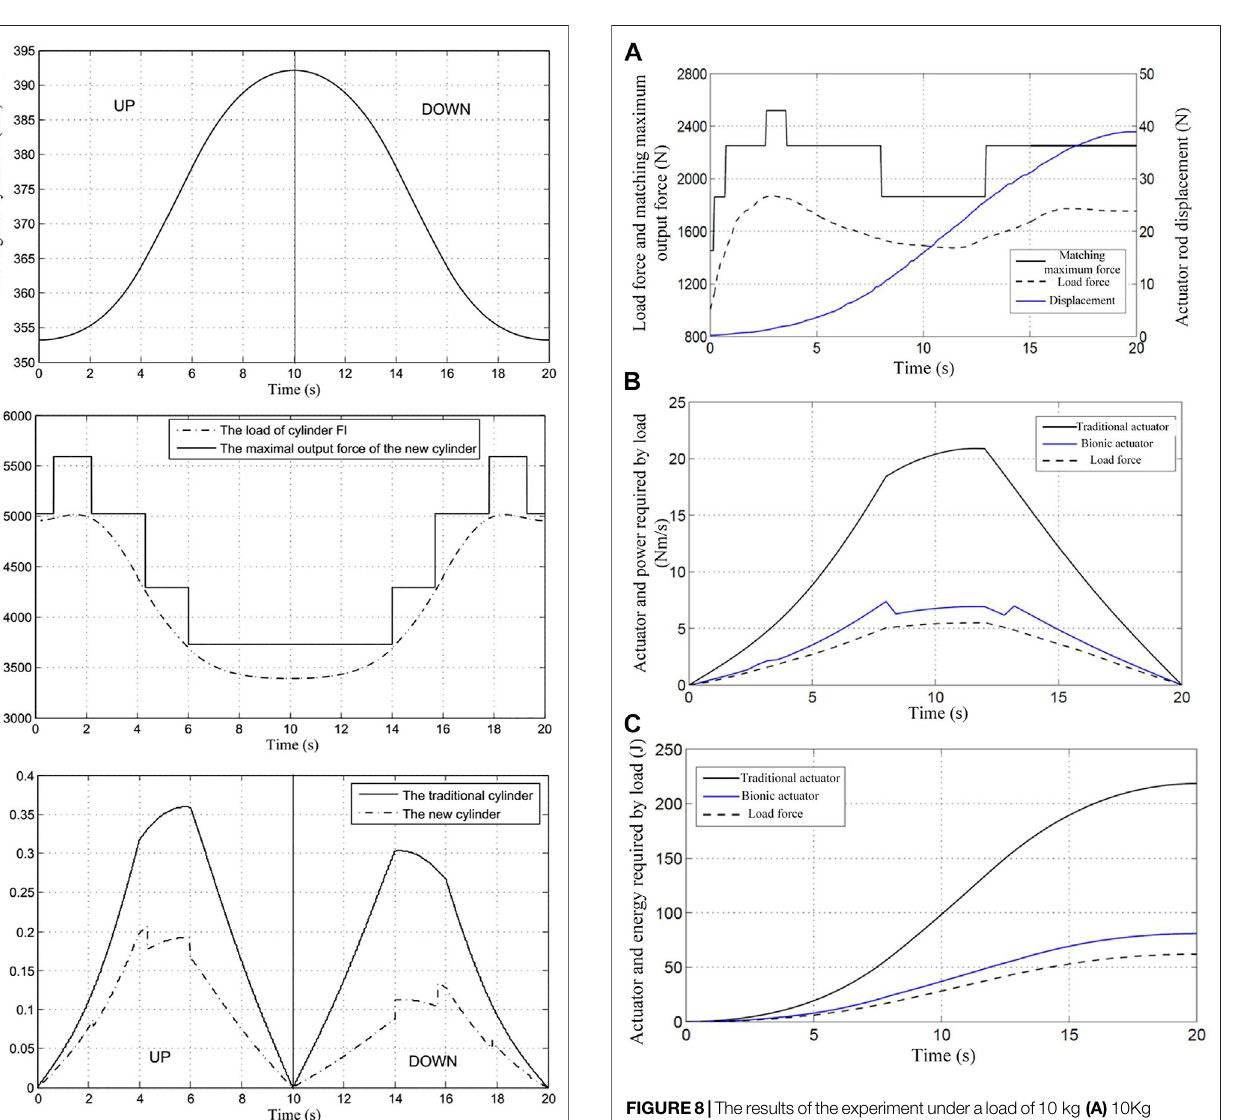
FIGURE8| Theresultsoftheexperimentunderaloadof10 kg (A) 10Kg load force matching; (B) 10Kg load power consumption curve; (C) 10Kg load energy consumption